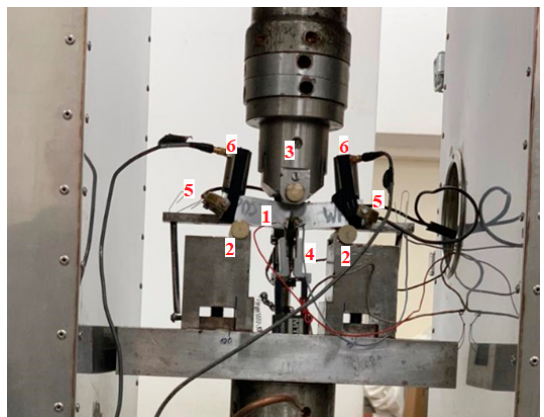
Figure 1. The view of the SENB specimen with AE sensors (Zwick-100, ZwickRoel Ulm, Germany) during test: 1—a sample, 2—support, 3—load cylinder, 4—COD extensometer, 5—AE sensors—100–1200 kHz, 6—AE sensors—30–80 kHz.